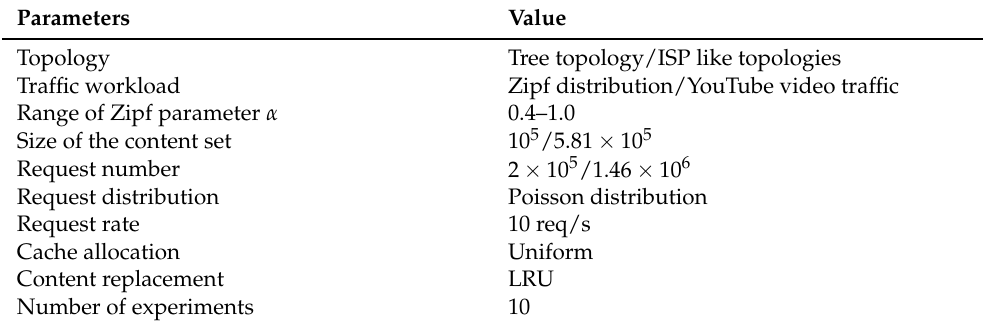
Table 2. Experiment